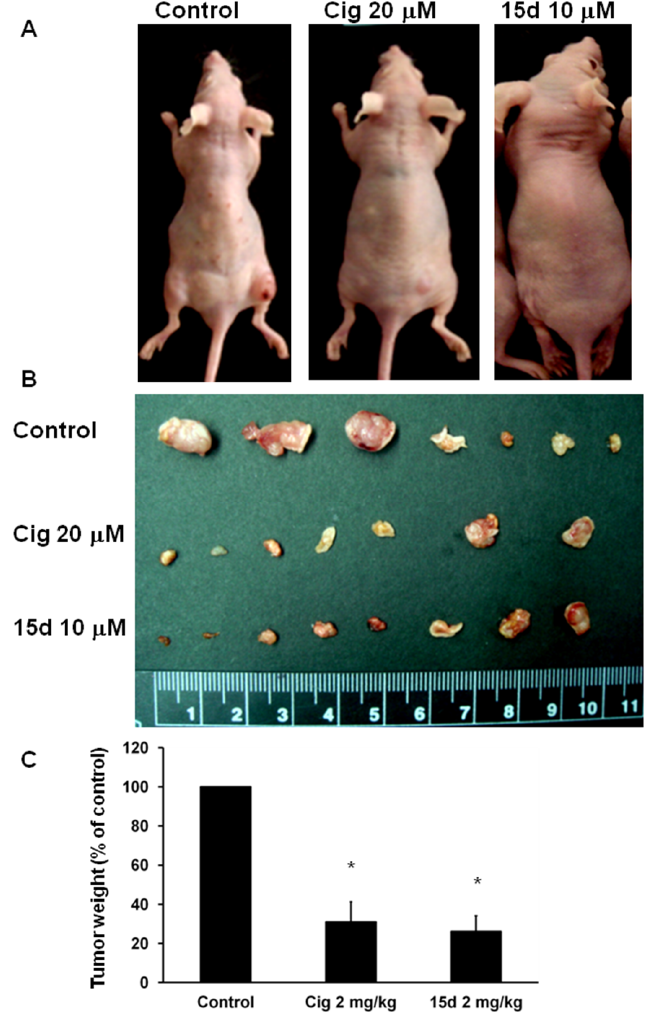
Figure 2. Effect of PPARγ agonists on human glioblastoma cancer cell (U87) tumor xenograft. U87 (5 × 10 6 cells) were injected subcutaneously at the flank of nude mice. When tumors grew to 5 mm in diameter, the mice were given vehicle ( n = 6), 2 mg/kg ciglitazone ( n = 6), or 2 mg/kg 15d-PGJ2 ( n = 6) twice a week for 10 days. ( A ) Representative photography of tumors in nude mice among different treatment group. ( B ) Photograph of tumor in different treatment group after removal from nude mice. ( C ) The weight of removed tumor in the different treatment group was measured. Data are presented as mean ± standard error (SE). *: p < 0.05.